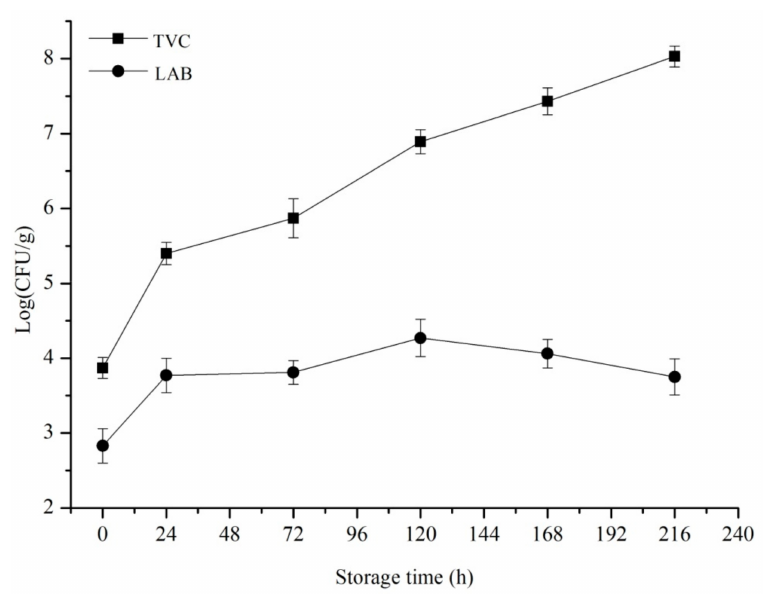
Figure 2. Changes in TVC (total viable count) ( (cid:4) ) and LAB (lactic acid bacterial) ( • ) of Spanish mackerel at 0 ◦ C cold chain storage. Data represent the mean ± SD values that were obtained from three